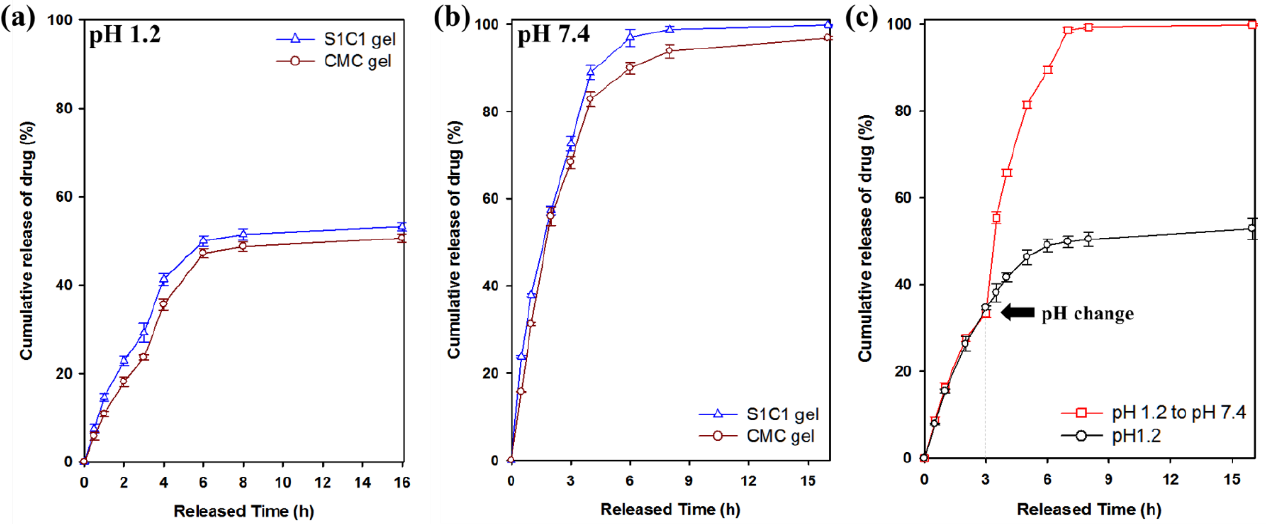
Figure 9. Cumulative release of 5-FU from of SG, CMC gel, and SG/CMC IPN hydrogels at 37 °C: ( a ) pH 1.2 condition; ( b ) pH 7.4 condition; ( c ) Change the pH from 1.2 to 7.4 after 3 h of experiment.